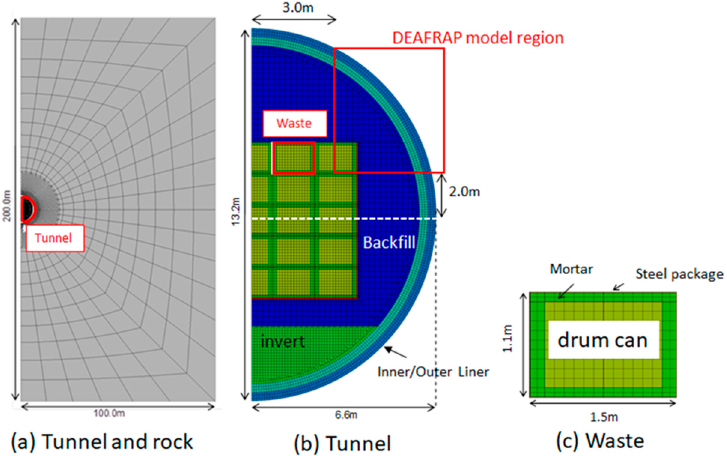
Figure 8. Whole model of the TRU Gr3 / 4 tunnel. The grid is constructed using quadrilateral and triangular elements. ( a ) Simulated tunnel and rock grid, ( b ) Zoomed view showing tunnel grid, ( c ) Zoomed view showing waste grid.